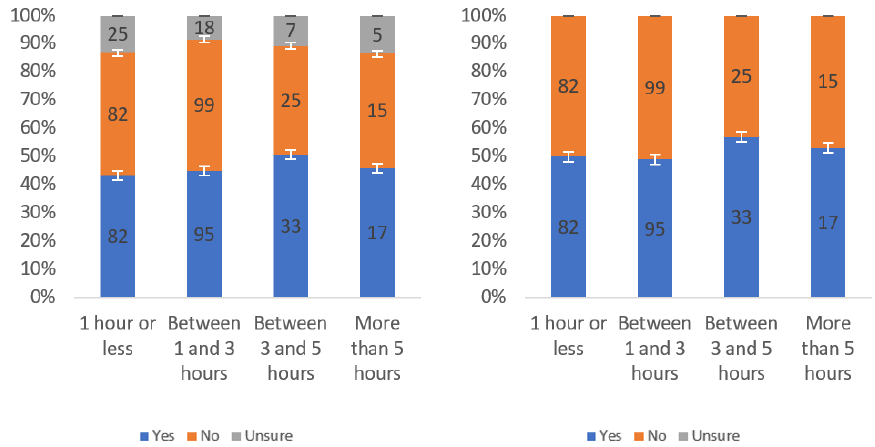
Figure A21. Responses regarding label annoyingness by internet usage level including ( left ) and excluding ( right ) unsure responses.